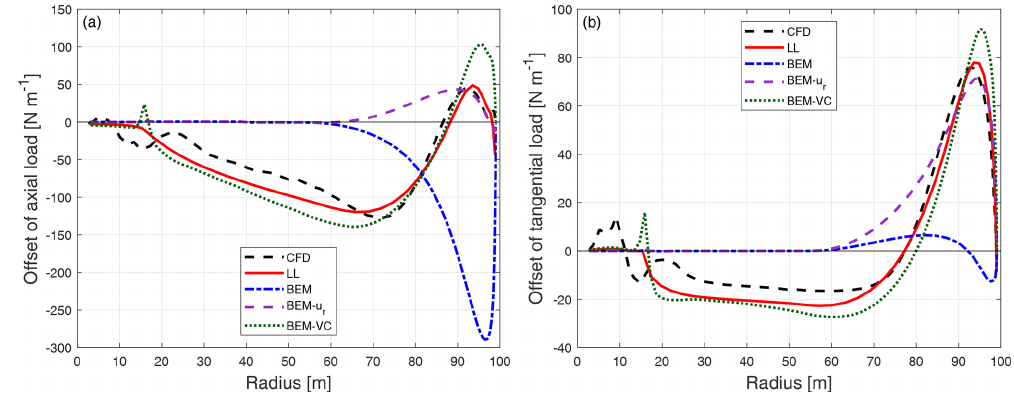
Figure B1. Comparison of the difference of the axial load (a) and tangential load (b) of the dihedral blade W-2 compared to the baseline blade calculated from CFD, the lifting-line method (LL), the BEM method, BEM with radial induction (BEM- u r ) and the proposed BEM-VC